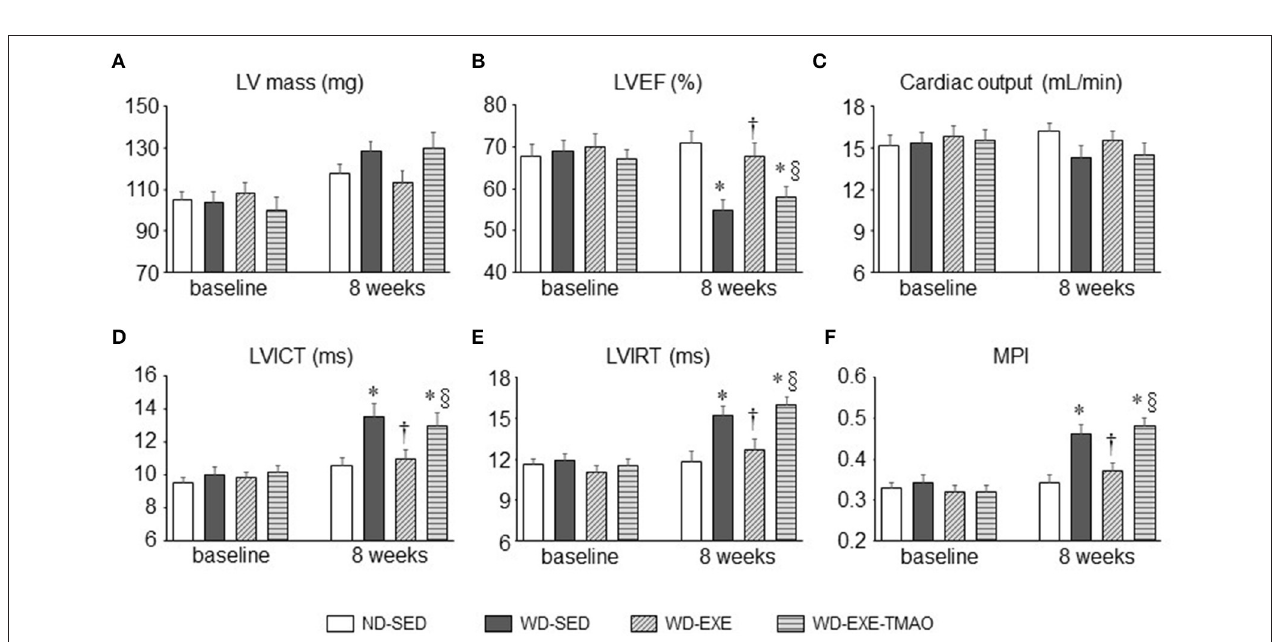
FIGURE 2 | Effects of voluntary exercise and TMAO supplementation on LV mass and cardiac function in mice fed a western diet (WD). Compared with normal diet (ND)-sedentary mice, WD-sedentary mice had impaired systolic (B) and diastolic function (D–F) at the end of the study protocol (8 weeks after feeding). Voluntary exercise, beginning at the start of WD feeding, prevented cardiac dysfunction, whereas concomitant administration of TMAO completely abolished the beneficial effect of voluntary exercise on cardiac dysfunction in mice fed a WD. No differences in LV mass (A) and cardiac output (C) were observed among the four groups. Sedentary: SED; voluntary exercise: EXE; LV, left ventricular; EF, ejection fraction; ICT, isovolumetric contraction time; IRT, isovolumetric relaxation time; MPI, myocardial performance index. Data are presented as mean ± SE ( n = 10 for each group). * P < 0.05 vs. ND-SED; † P < 0.05, WD-EXE vs. WD-SED; § P < 0.05, WD-EXE-TMAO vs.